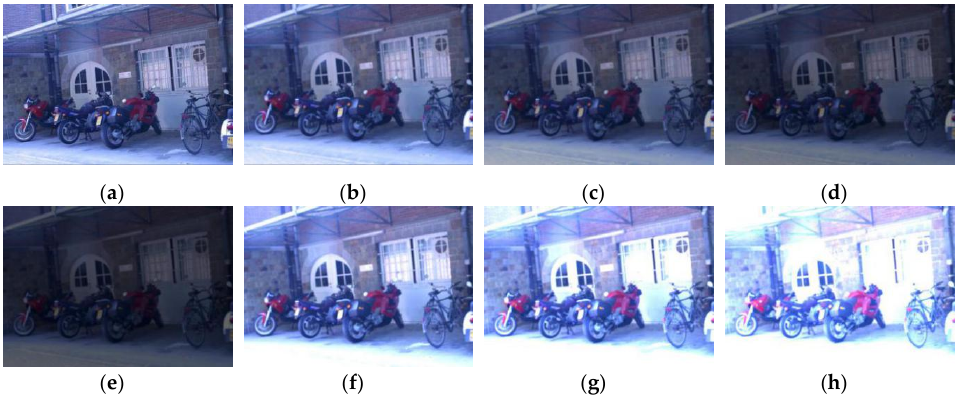
Figure 5. Bikes sequence. ( a ) Normal Bikes; ( b ) New Bikes with increasing blur; ( c ) New Bikes in an underexposure of − 1; ( d ) New Bikes in an underexposure of − 2; ( e ) New Bikes in an underexposure of − 3; ( f ) New Bikes in an overexposure of + 1; ( g ) New Bikes in an overexposure of + 2; and ( h ) New Bikes in an overexposure of + 3.